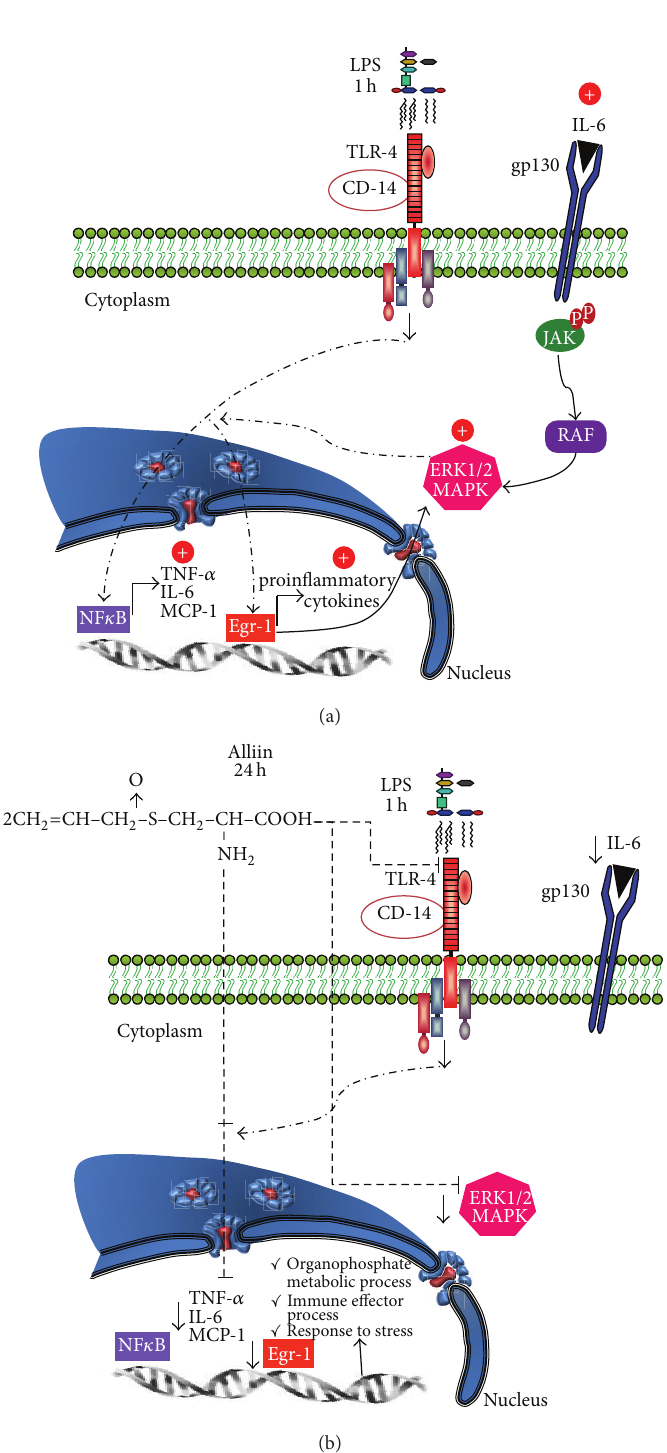
Figure 4: A proposal of how alliin could counteract the inflammatory state promoted by lipopolysaccharides (LPS) in 3T3-L1 adipocytes. (a) Activation of proinflammatory signaling pathway by lipopolysaccharides (LPS). (b) Alliin could reduce the Toll-like receptor-4 (TLR-4) pathway, possibly by diminishing the expression of related genes and proteins such as interleukin-6 (IL-6), monocyte chemostatic protein-1 (MCP-1), and early growth receptor-1 (Egr-1) and therefore regulates extracellular signal-regulated kinase (ERK1/2)